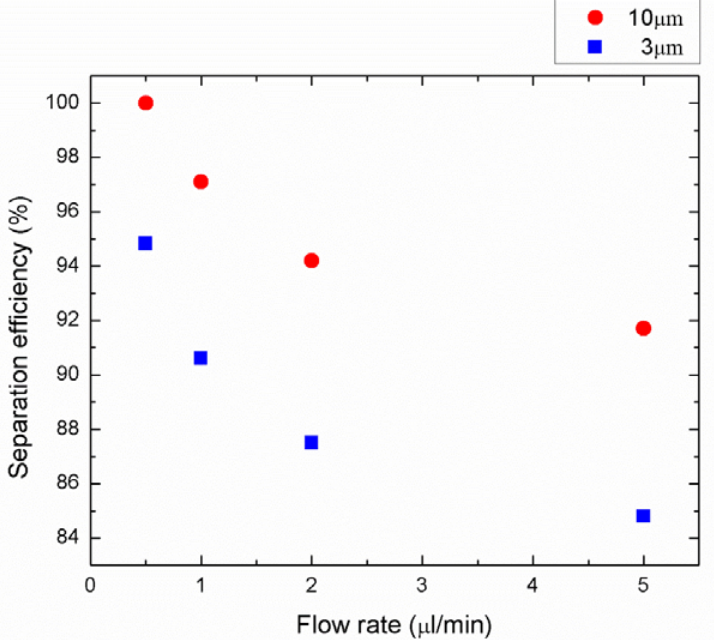
Figure 11. Separation efficiency as a function of flow rate for 3 and 10 μ m particles (driving frequency: 13.2 MHz, input power: 1 W, particle concentration: 1% by volume).